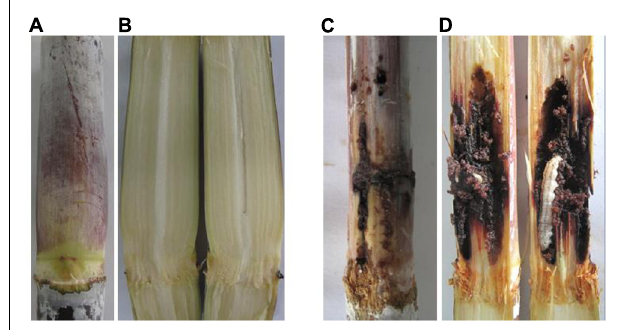
FIGURE 6 | Comparison of cane borer damage between transgenic and control line stalks. (A) Stem symptom of transgenic lines (grew healthy and did not destroy by cane borer); (B) Stem symptom of transgenic lines (inside stalk); (C) Stem symptom of control lines (Destroyed badly by cane borer); (D) Stem symptom of control lines (inside stalk grew with cane